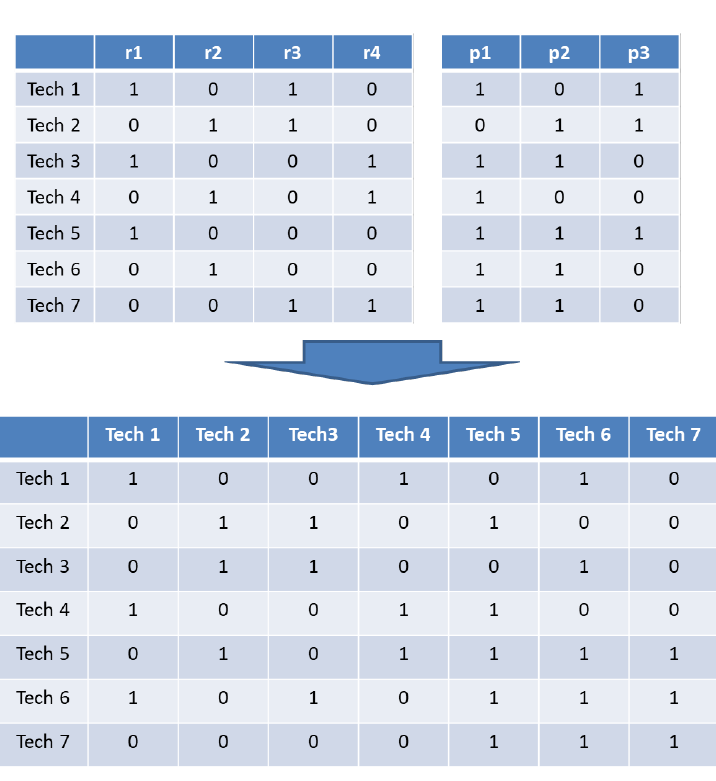
Figure 3. Compatibility matrix obtained from the example depicted in Figure